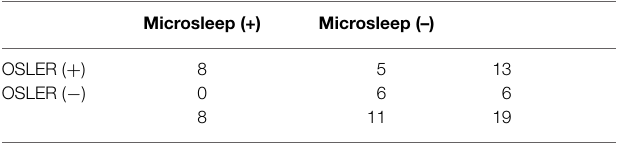
TABLE 4 | Sensitivity of OSLER test for microsleeps